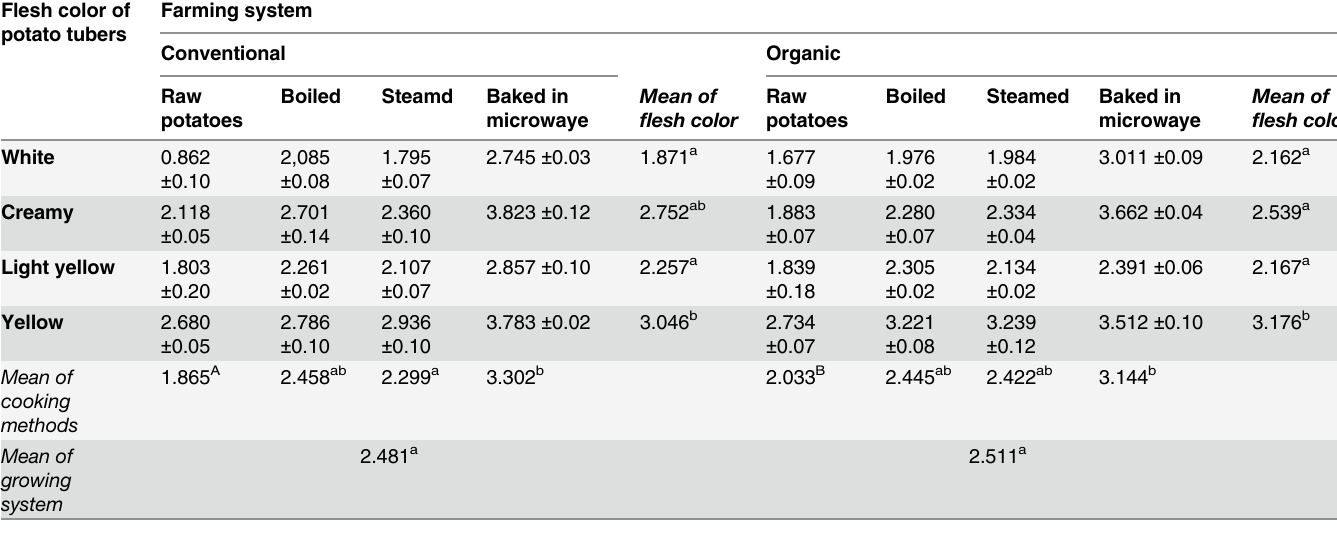
± , standard error of the mean Mean values in columns denoted by the letters (a, b, c) are statistically signi fi cant P (cid:4) 0,05.